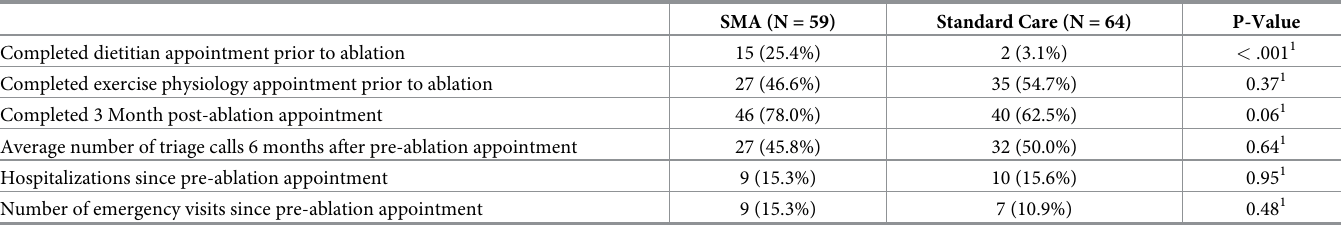
Table 5. Differences in healthcare utilization between patients in SMA and standard care �